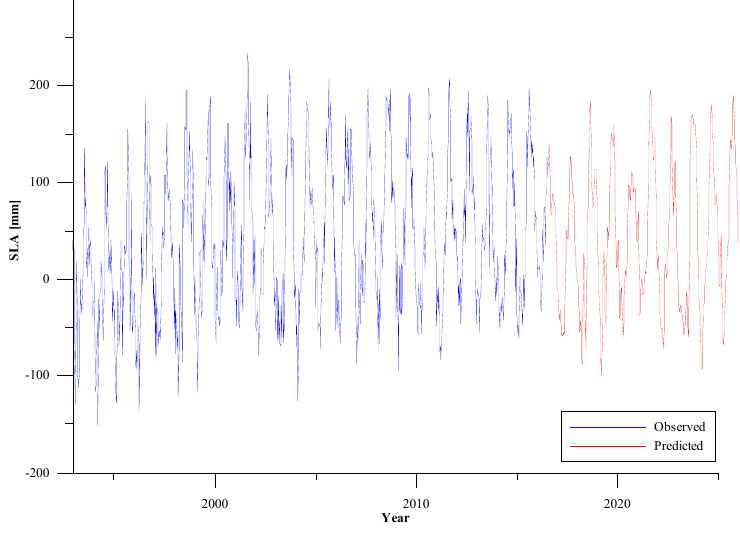
Figure 7. Estimated SLAs with CEEMD-RBF combined model from 2016 to 2025 around Shandong Peninsula.